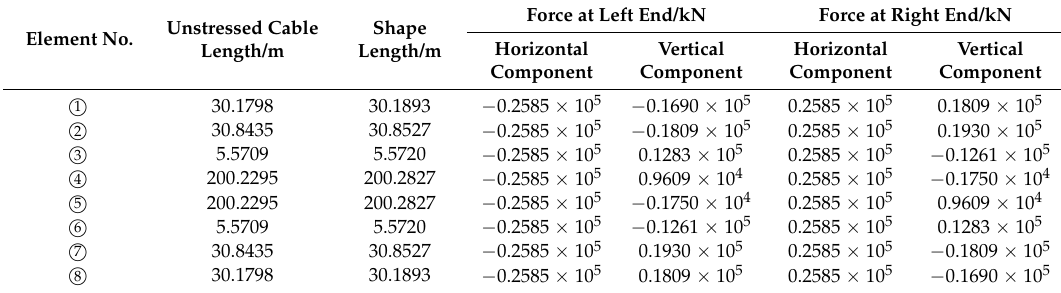
Table 2. Results of the length and tension force of each cable element under load case 1. Element No.